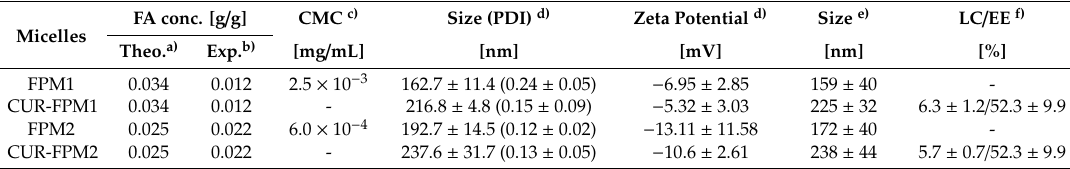
Table 1. Characterizations of the FPM micelles.